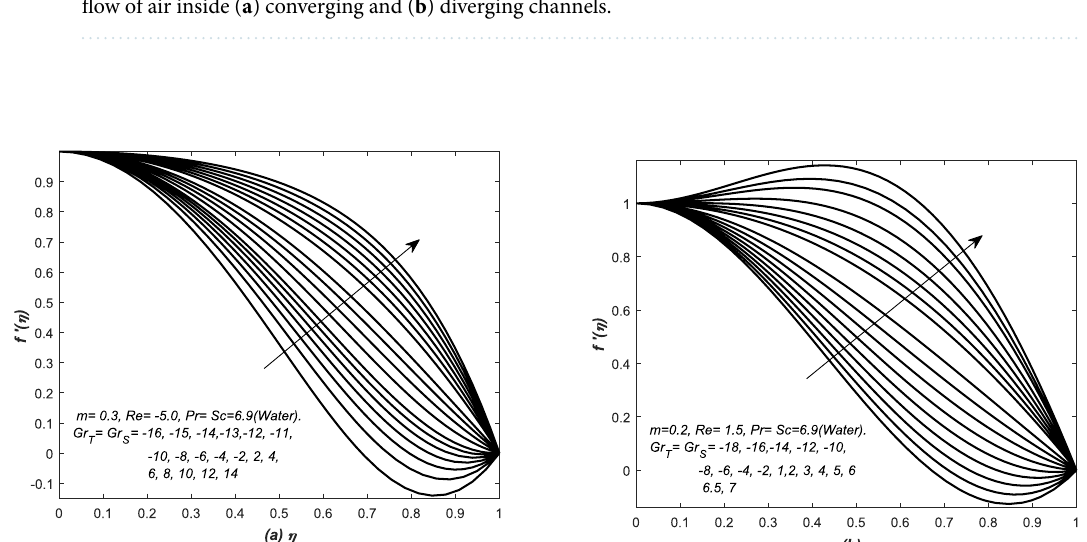
Figure 8. The dimensionless velocity f ′ (η) is plotted against the similarity variable η for assisting and opposing flow of water inside ( a ) converging and ( b ) diverging